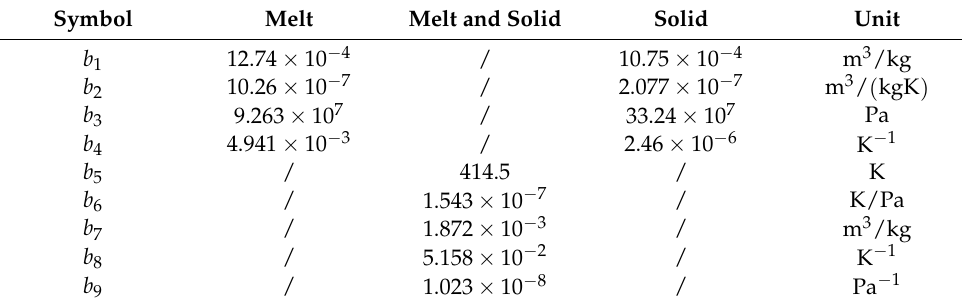
Table 2. Tait equation parameters for HDPE Sabic M80064 [35].